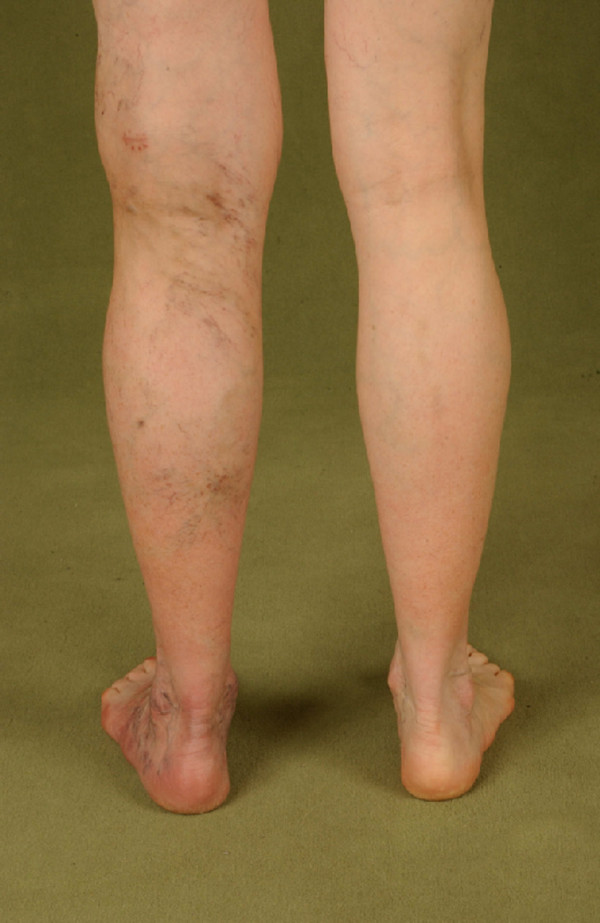
clinical aspect of SFT. Clinical aspect of a solitary fibrous tumor of the lower left leg: swelling with soft tissue mass (same patient as in fig. 3).